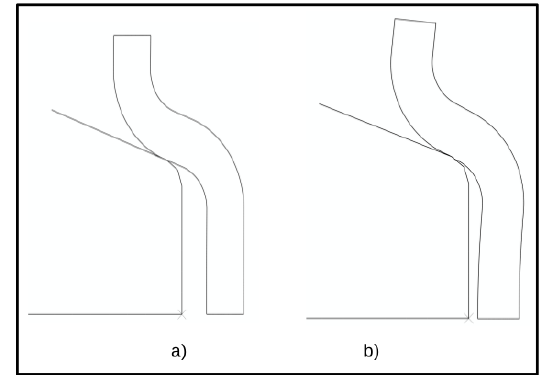
Figure 11: V-band- flange assembly (a) no deflection in v-band and constant contact angle (b) Deformation in v-band and variable (in- crease) in contact